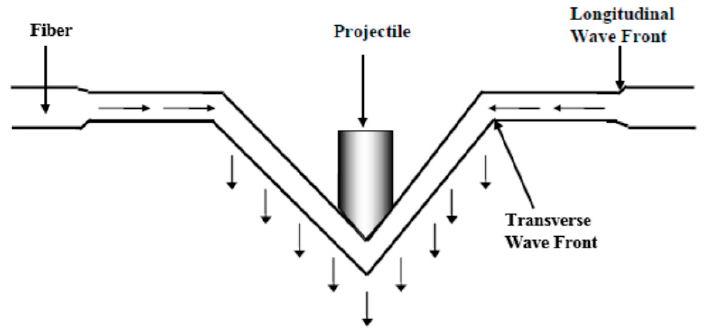
Figure 4. Mechanism of ballistic protection. (Adapted with copyright permission from Cheeseman and Bogetti [19]). Table 1. List of standards on different armor type.